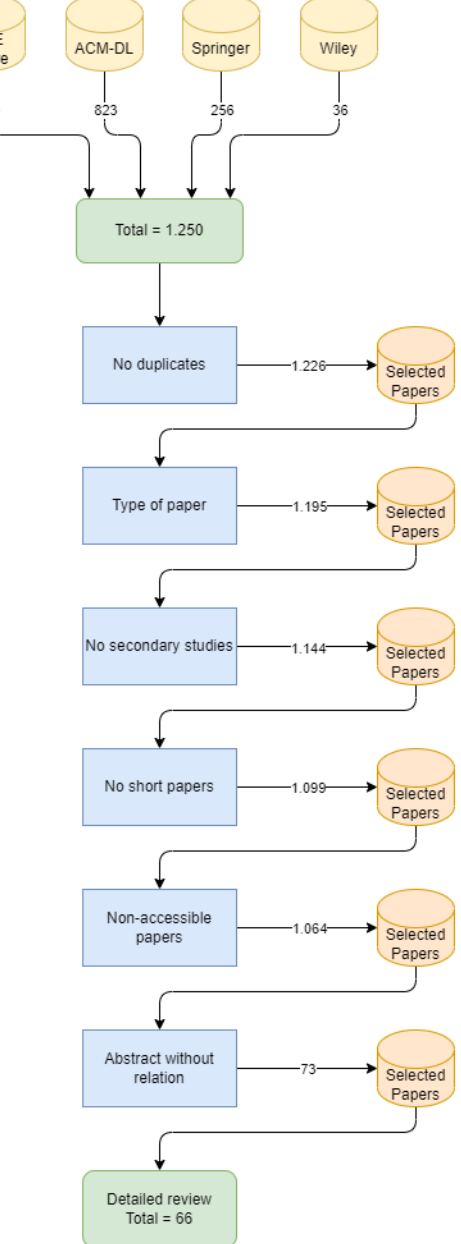
Figure 6. SMS primary study selection